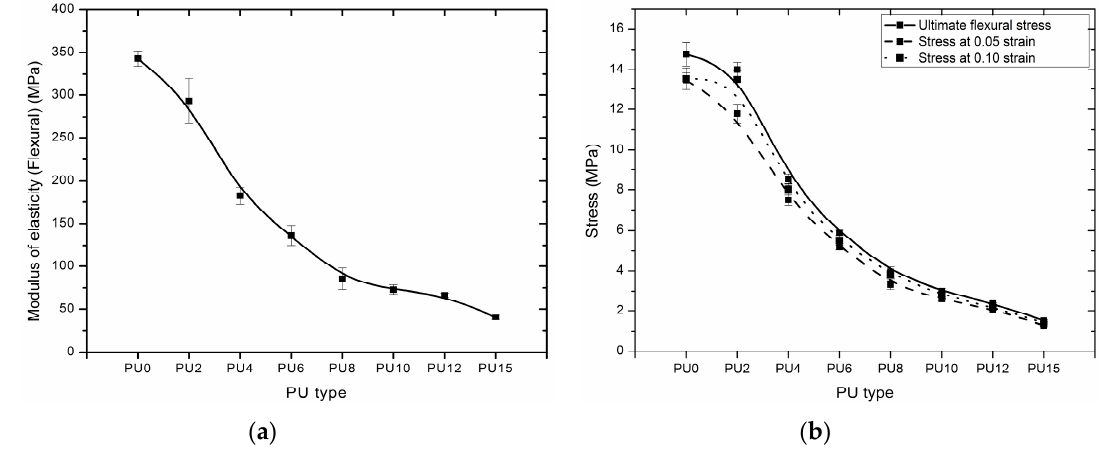
Figure 12. Comparison of ( a ) modulus of elasticity (flexural); ( b ) stresses at 0.05 and 0.10 strains of the PUs (PU0–PU10 are types of PU and PU6—PU which contained 6% PEG).